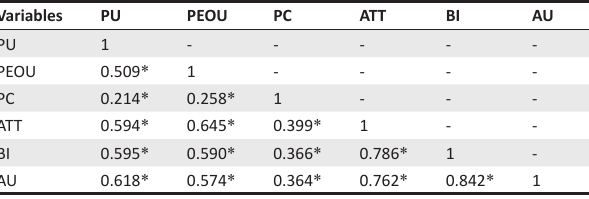
TABLE 3: Correlation matrix.